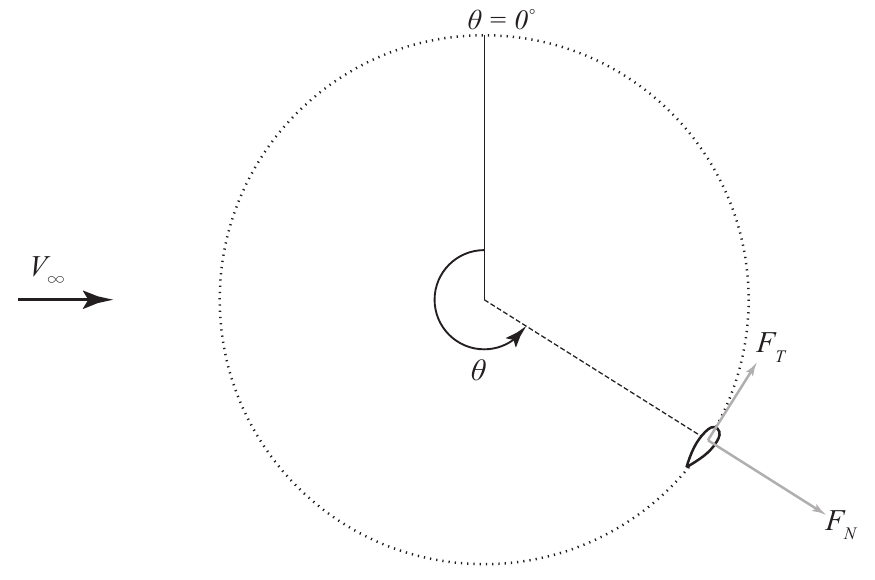
Figure 5. The sign convention of the normal and tangential forces. The counter-clockwise direction of the blade azimuth angle θ is defined as